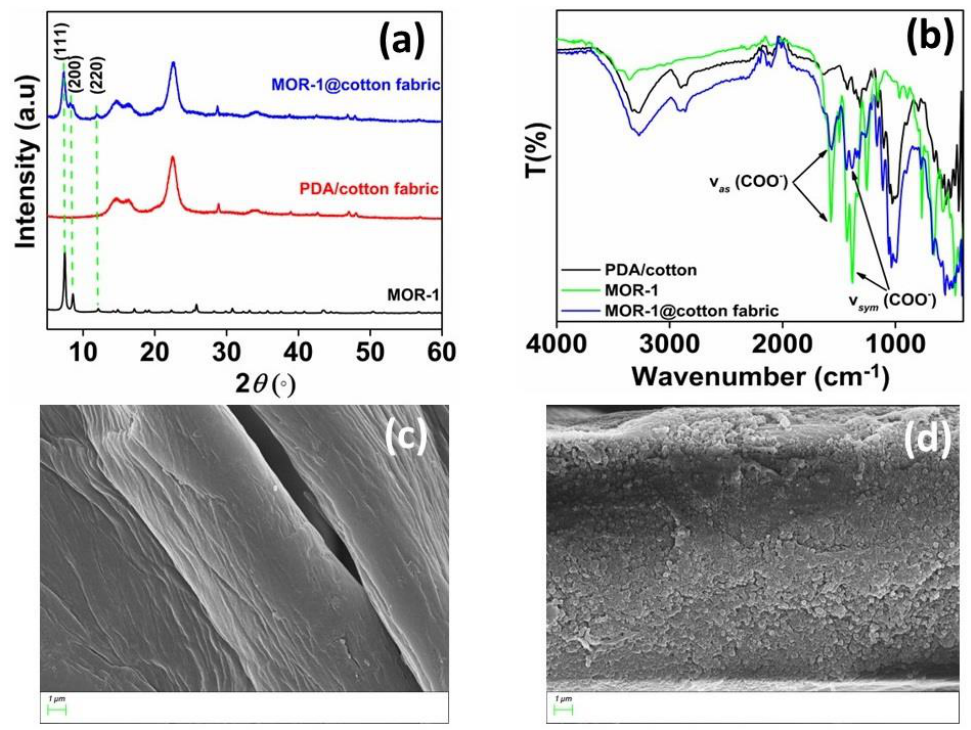
Figure 2. ( a ) PXRD pattern of MOR − 1, PDA/cotton fabric, and MOR − 1@cotton fabric, ( b ) FT − IR of MOR − 1, PDA/cotton fabric, and MOR − 1@cotton fabric and SEM images of ( c ) PDA/cotton fabric and ( d ) MOR − 1@cotton fabric.